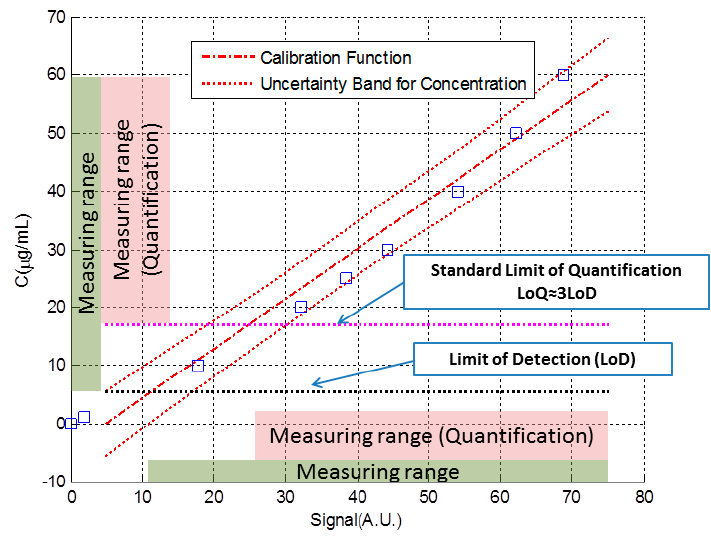
Figure 6. Data, calibration line, uncertainty band, limits of detection and quantification and measuring